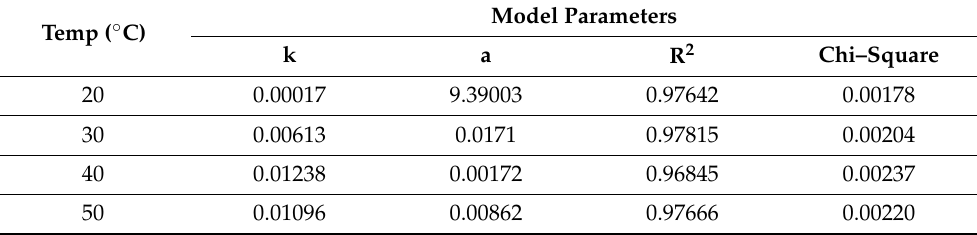
Table 3. The kinematic parameters of the Singh et al., model at the temperature range of 20–50 ◦ C. Temp ( ◦